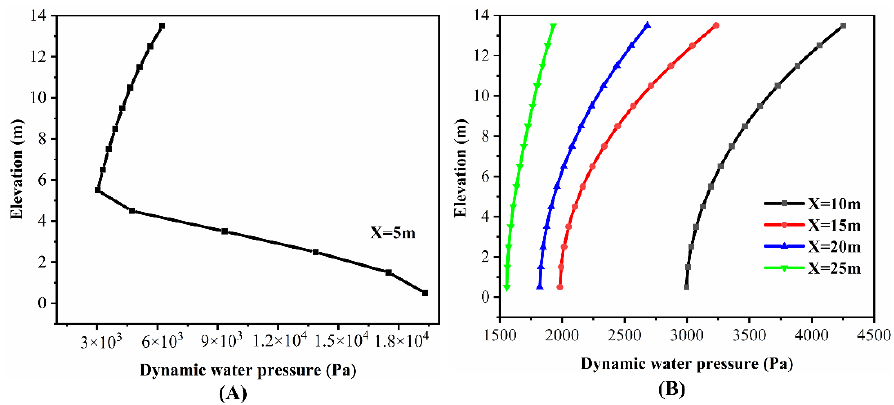
Figure 10. Distribution of dynamic water pressure by elevation in different distances between dam site and landslide location: ( A ) X = 5 m; ( B ) X = 10, 15, 20, 25 m.